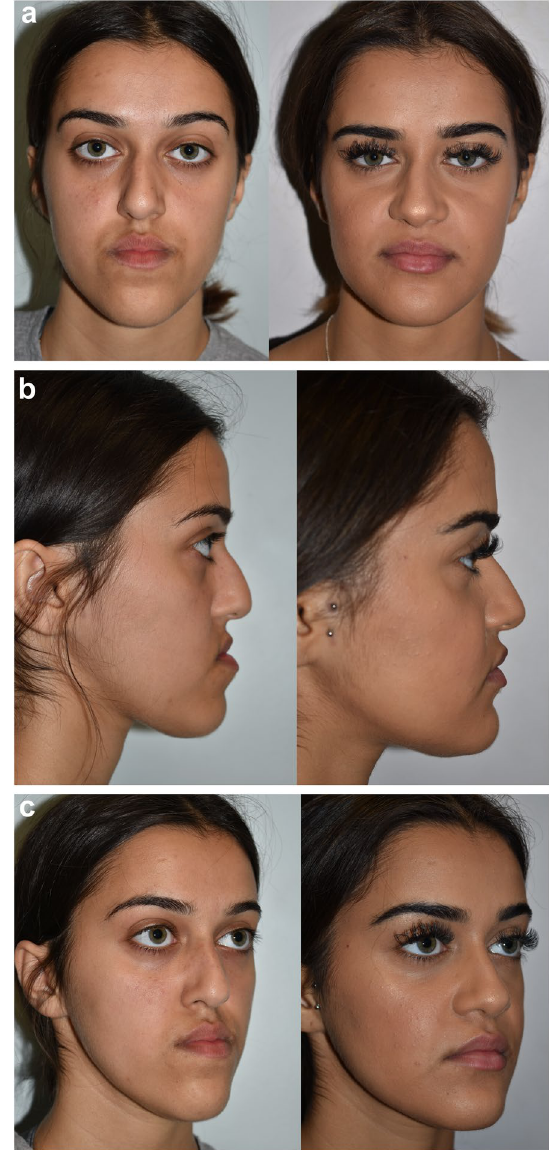
Fig. 7 a Preoperative and end of treatment frontal images. b Preoperative and end of treatment profile images. c Preoperative and end of treatment oblique lateral